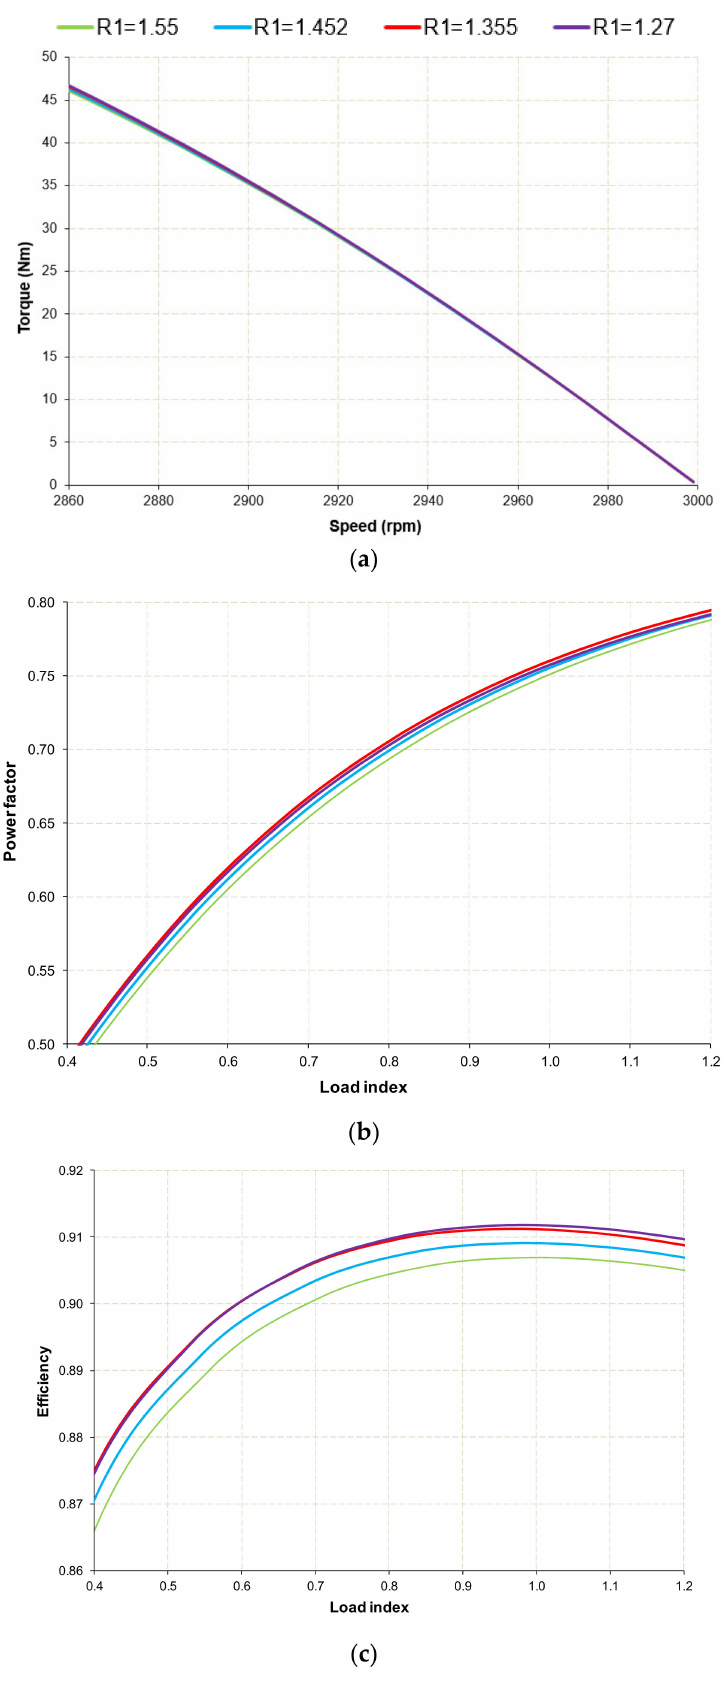
Figure 3. Characteristic curves in the 7.5 kW motor (variations of R 1 in Ω ). ( a ) Torque-speed (stability zone); ( b ) Power factor-load index; ( c ) Efficiency-load